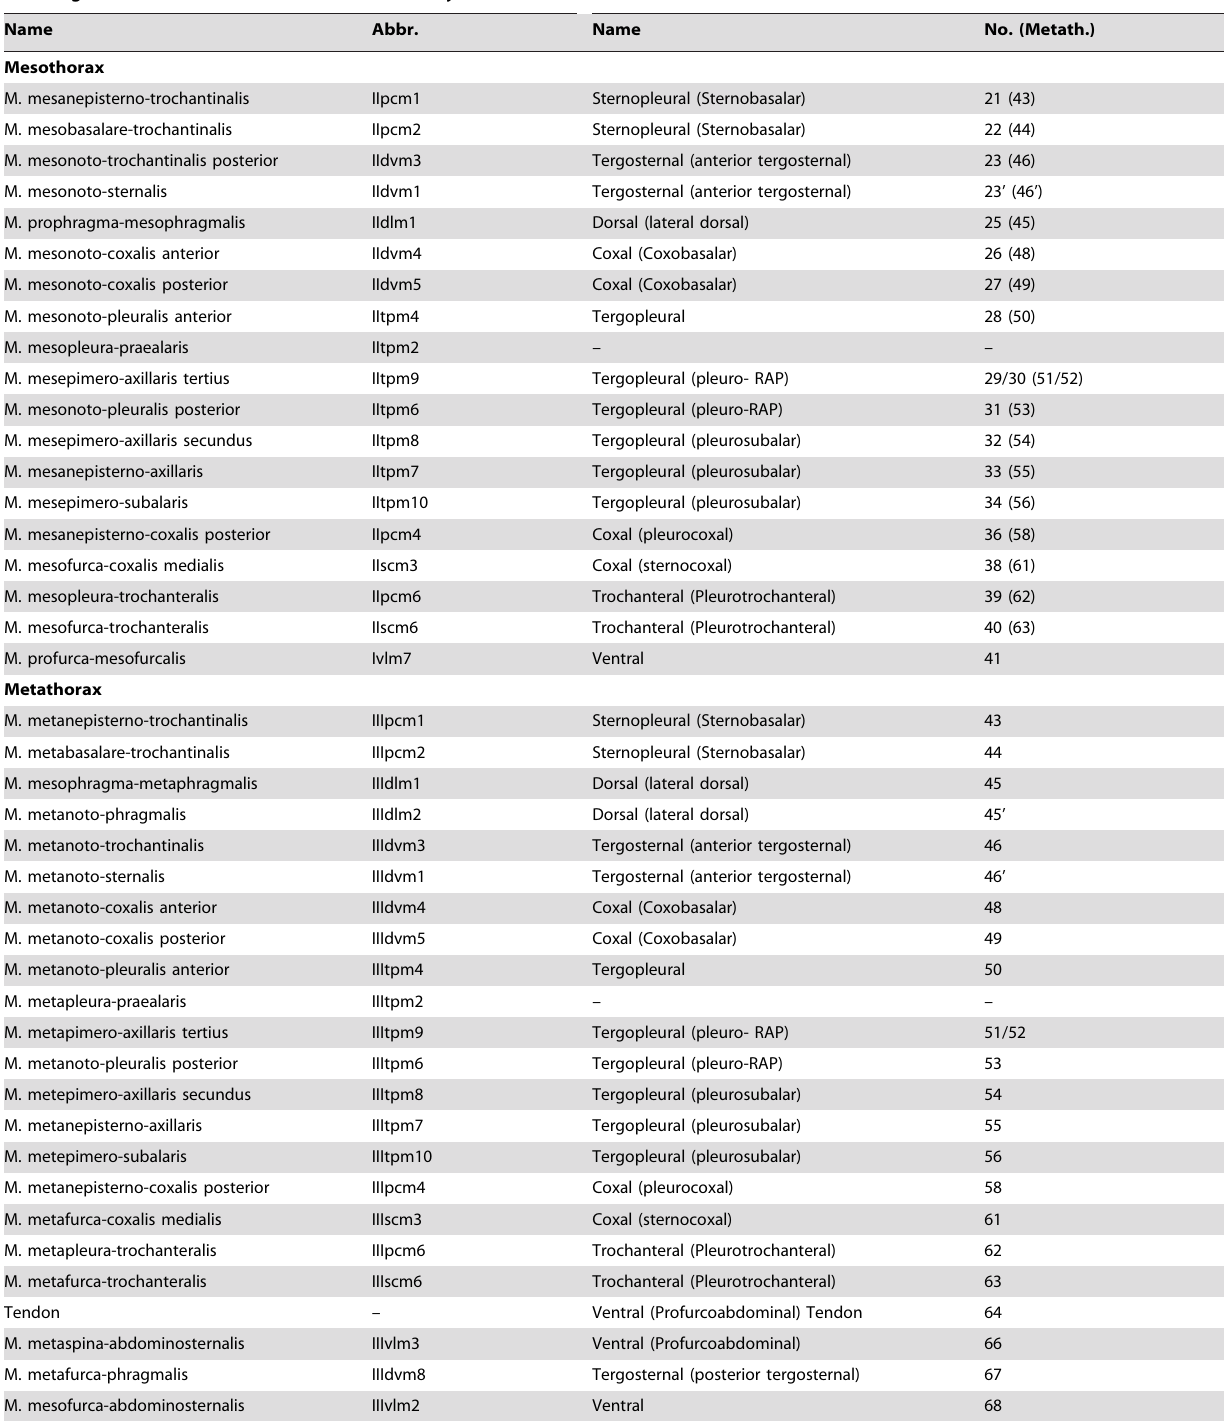
Homologies (Friedrich & Beutel (2008) and this